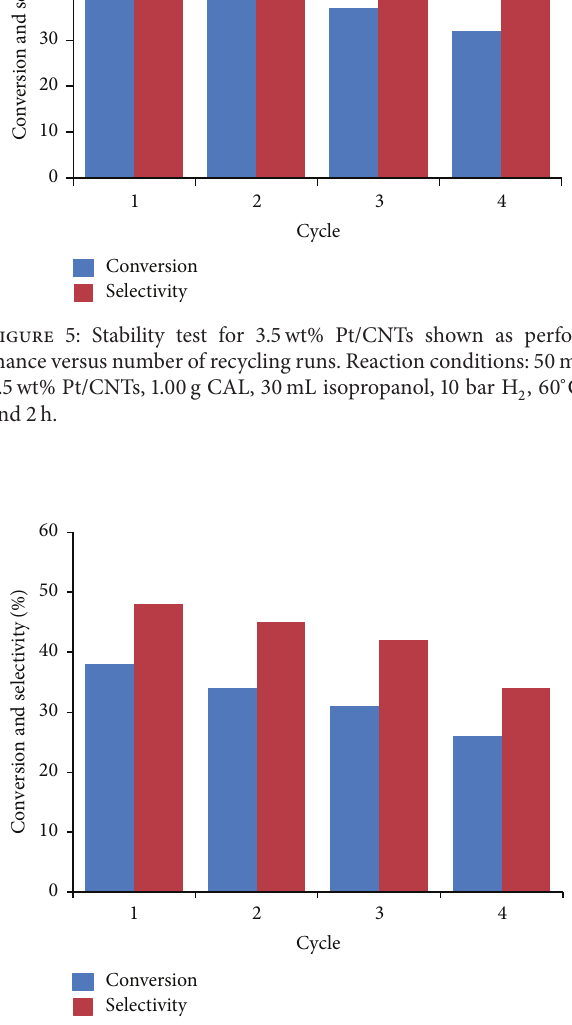
Figure 6: Stability test for 3.5 wt% Pt/RGO@SiO 2 shown as perfor- mance versus number of recycling runs. Reaction conditions: 50 mg 3.5 wt% Pt/RGO@SiO 2 , 1.00g CAL, 30 mL isopropanol, 10 bar H 2 , 60 ∘ C, and